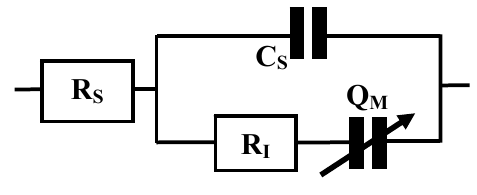
Fig. 3: Equivalent circuit of